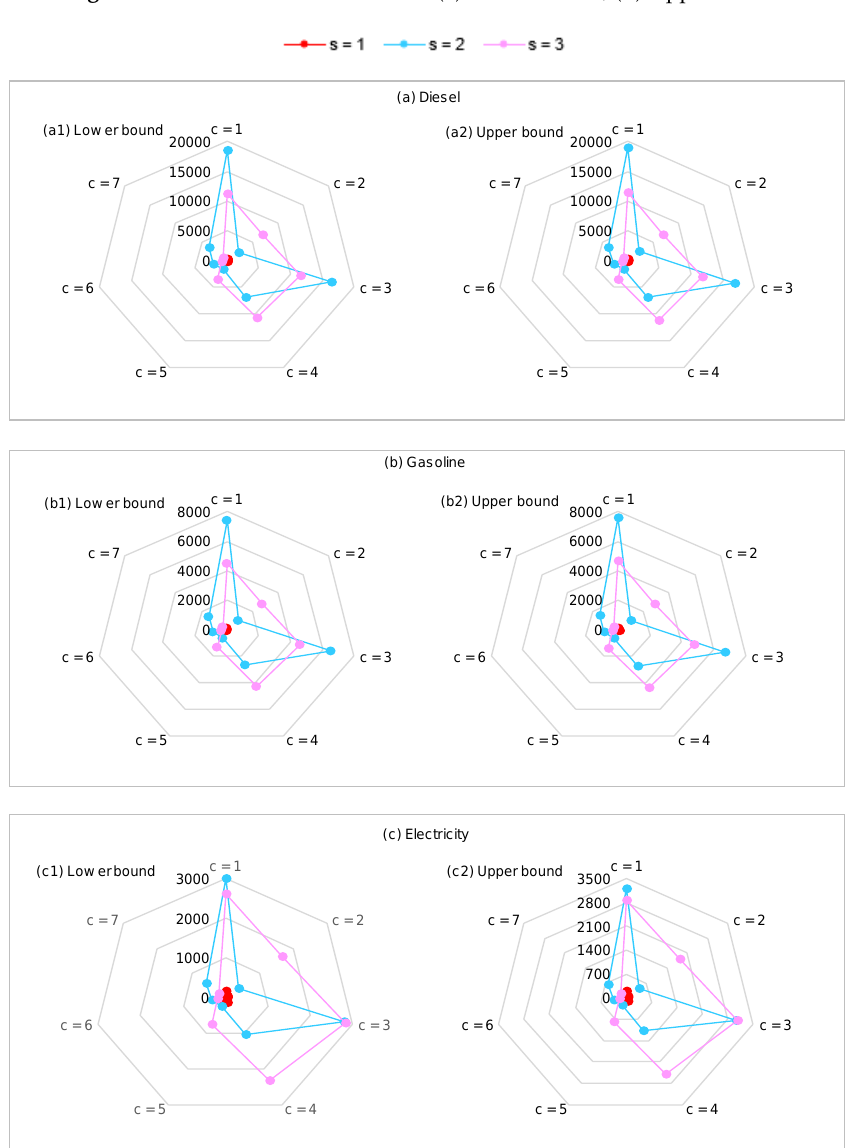
Figure 8. Energy consumption: ( a ) Diesel, ( b ) Gasoline, ( c ) Electricity.